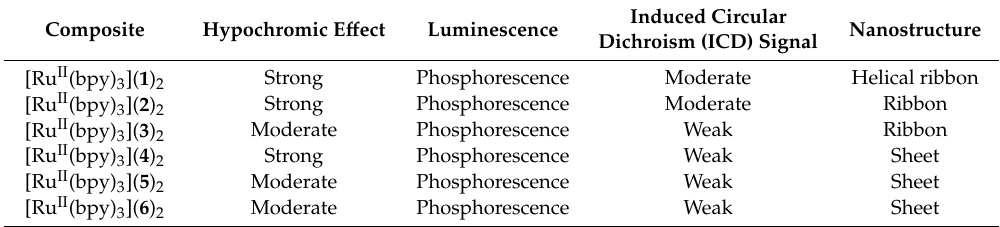
Table 2. Summary of characteristics of [Ru II (bpy) 3 ](lipid) 2 (lipid = 1 – 6 ) complexes in EtOH at 298 K